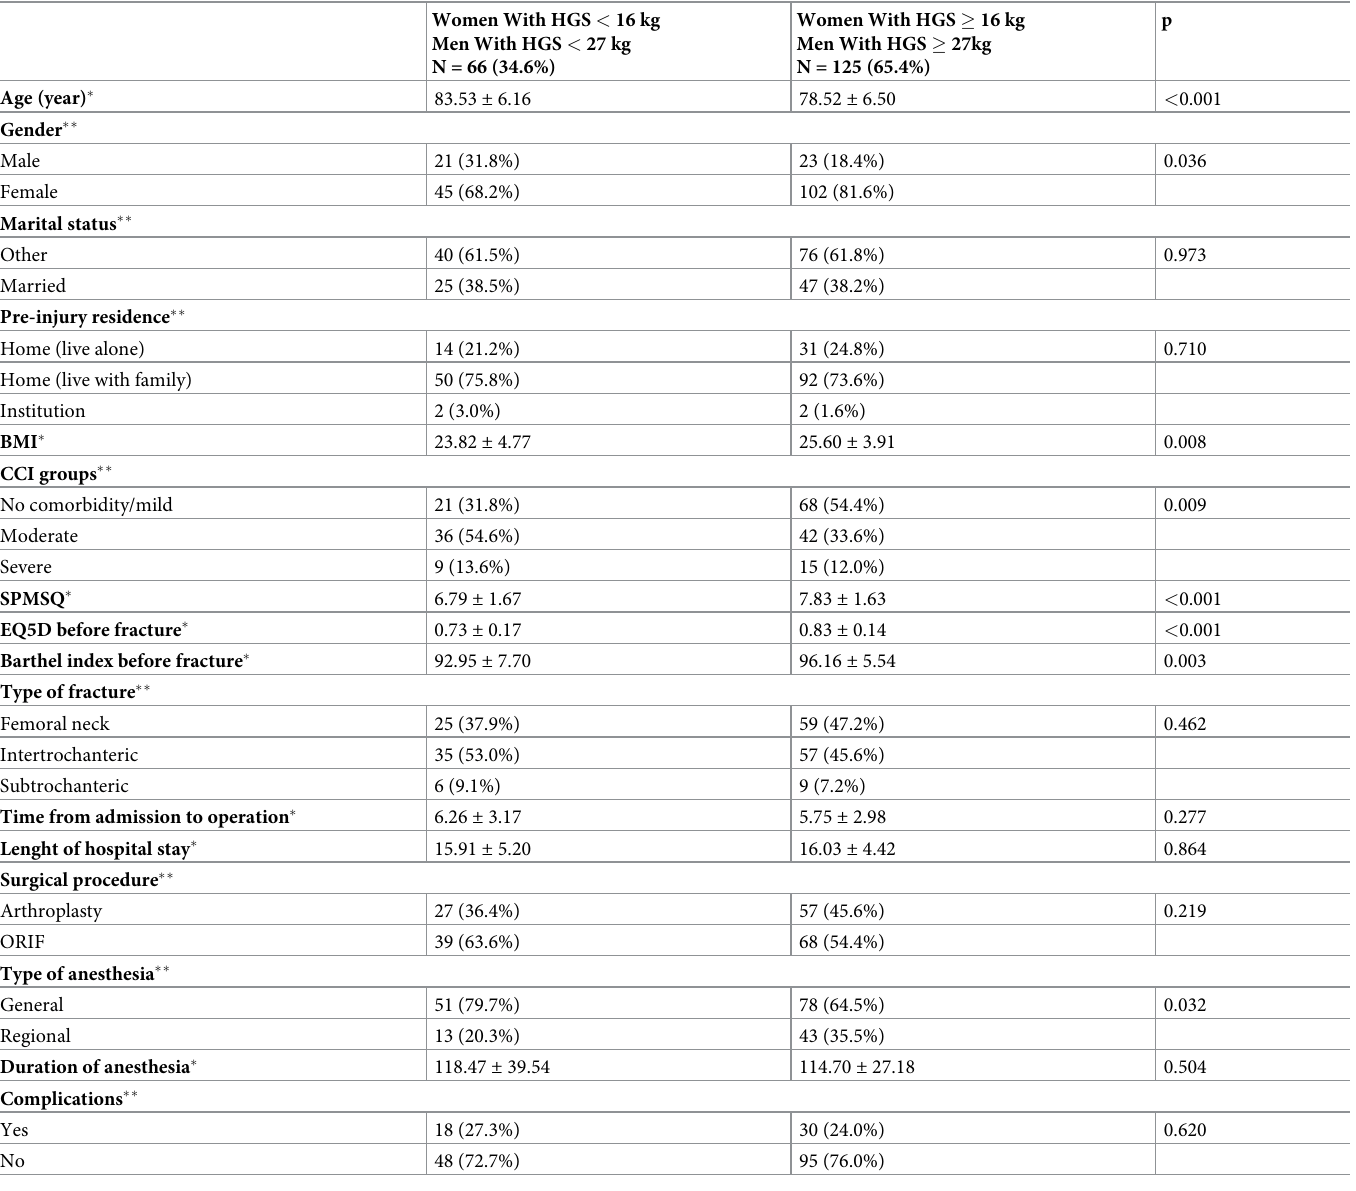
Table 1. Socio-demographic and baseline pre- and perioperative characteristics of the participants.